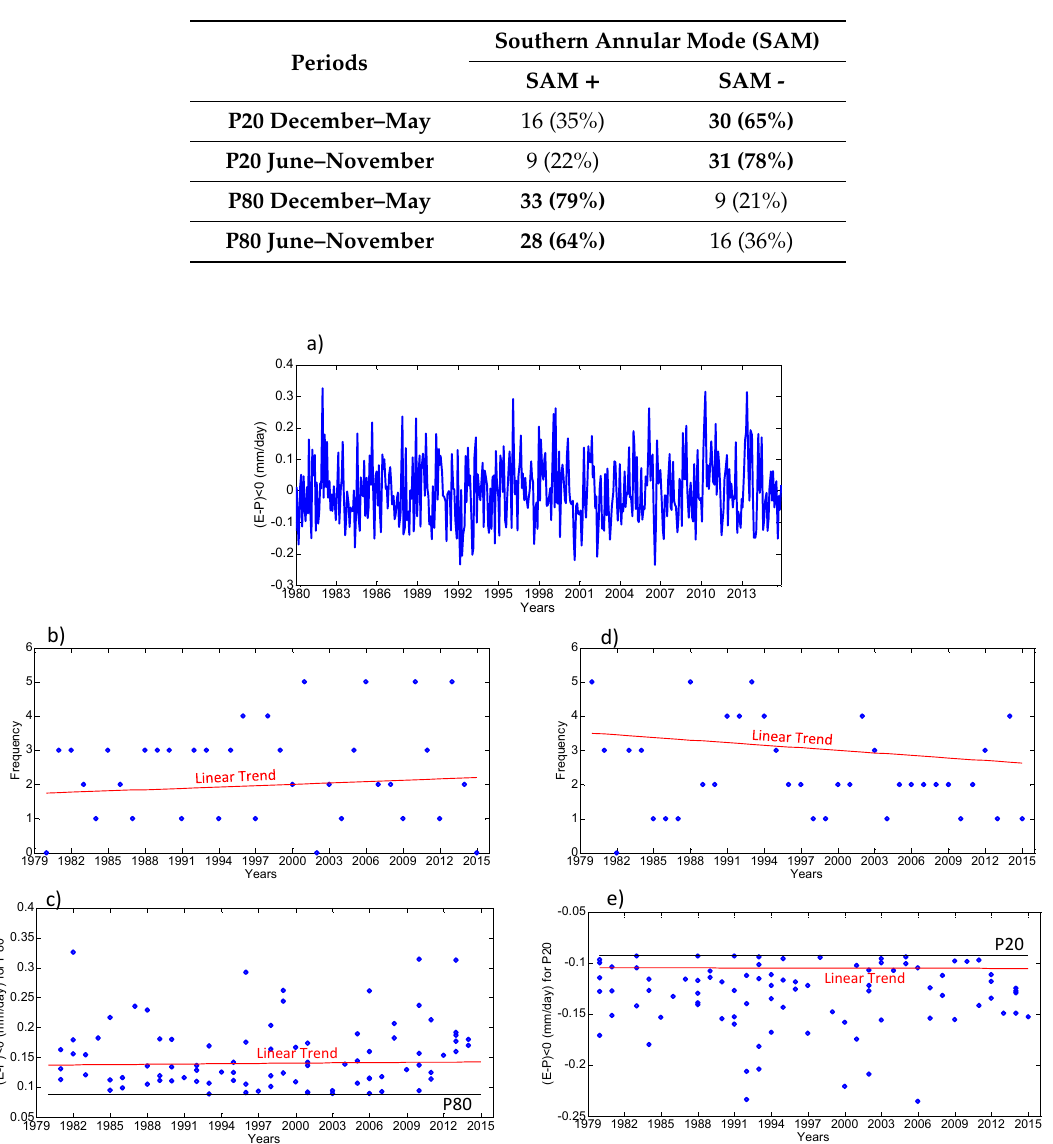
Figure 8. Time series of moisture sink (mean value over the blue area in Figure 2 multiplied by − 1) for the Weddell Sea: ( a ) monthly anomaly (mm / day), ( b , c ) annual frequency and intensity (mm / day) of the moisture sink anomaly exceeding P80, ( d , e ) annual frequency and intensity (mm / day) of the moisture sink anomaly lower than P20.